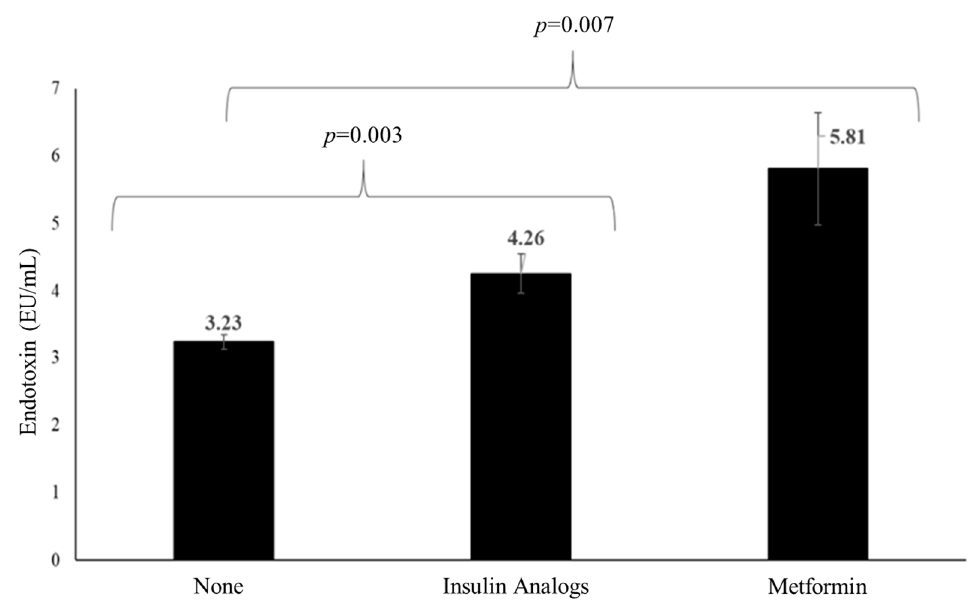
Figure 1. Differences in endotoxin levels according to anti-T2DM medications.